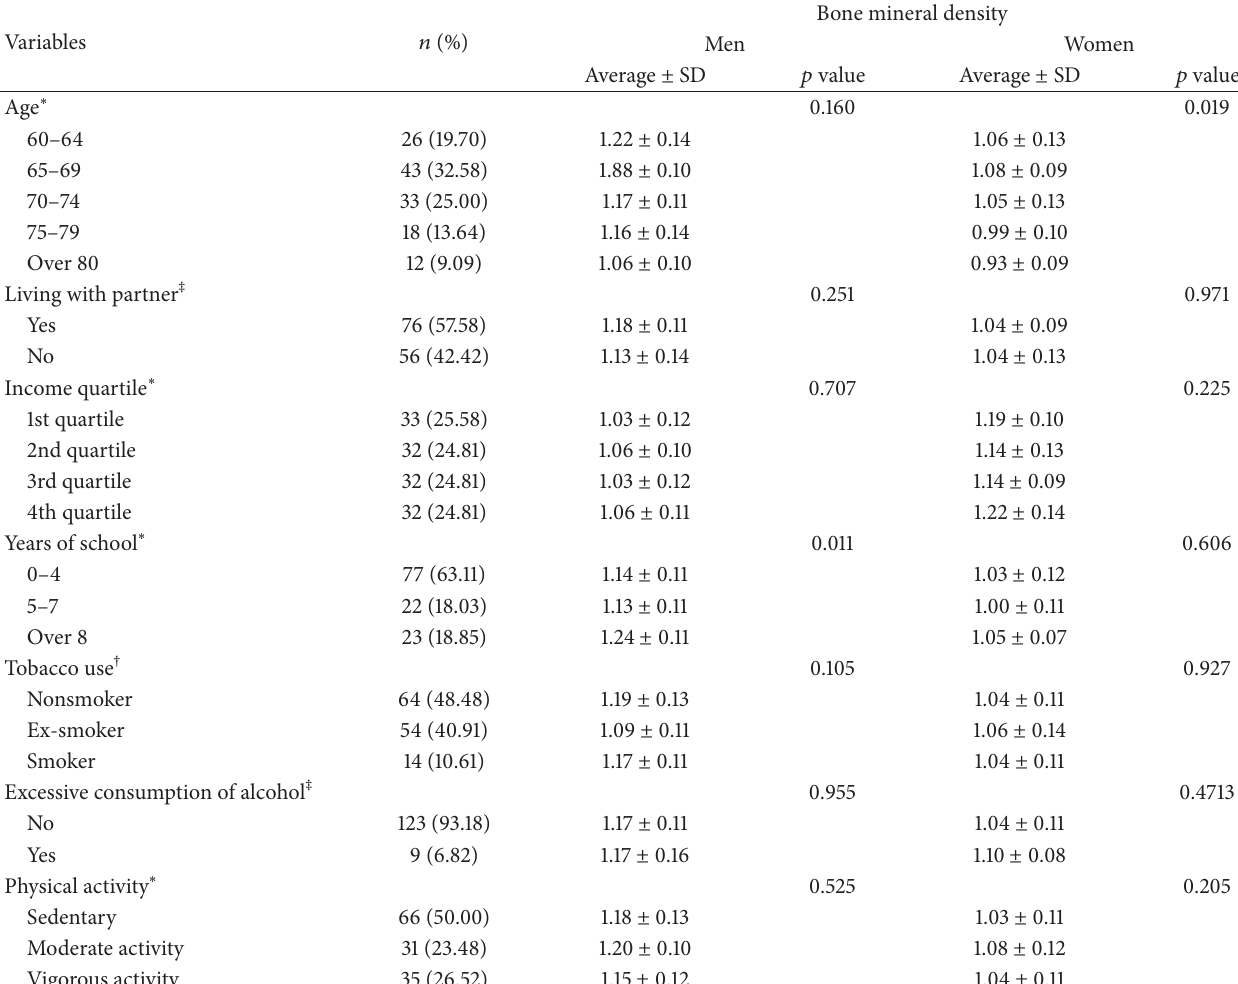
Table 2: Bone mineral density in the elderly, by sex, and association with sociodemographic and lifestyle variables, Goiˆania, GO, 2009. 𝑛 = 132 .